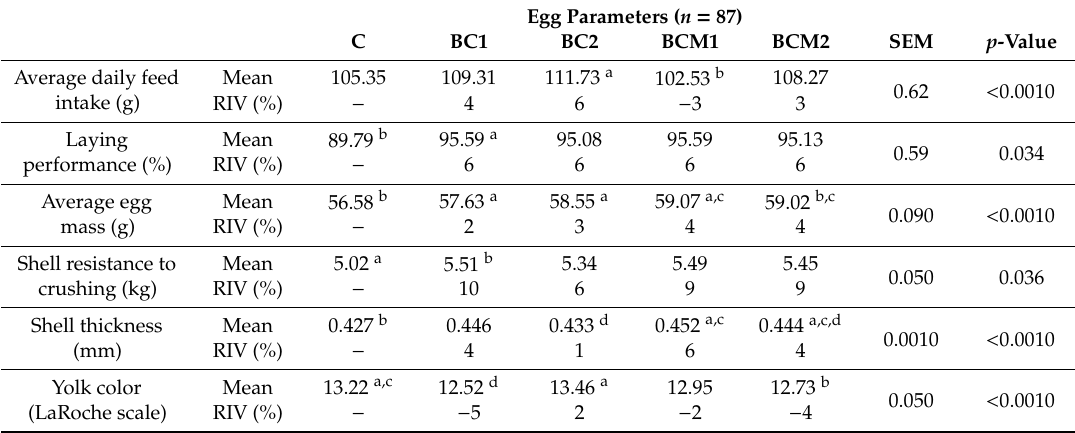
Table 7. Mean feed intake and egg parameters of biochar-fed laying hens.